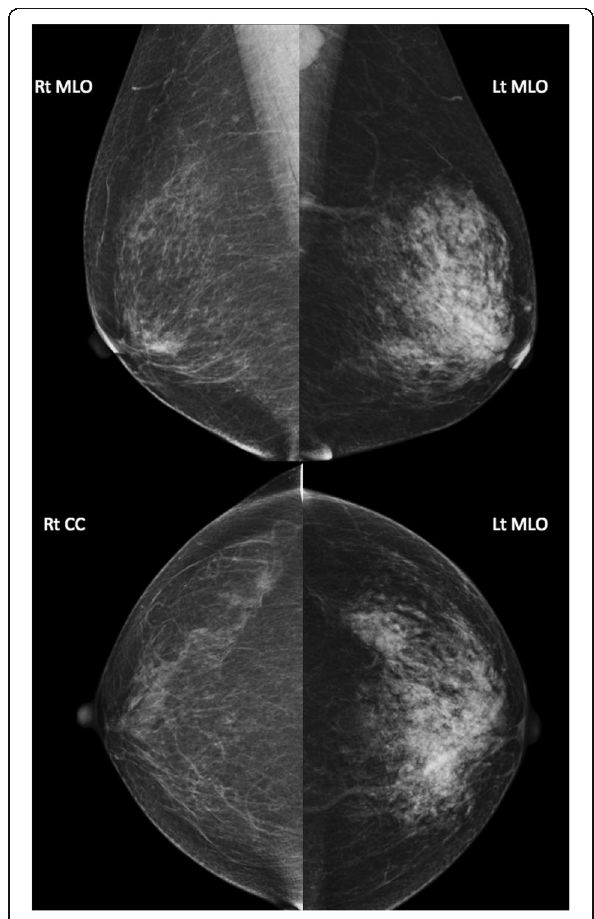
Fig. 1 Mammography findings. Medio-lateral oblique (MLO) and cranio-caudal (CC) images are shown. No apparent tumor shadow or calcification was observed in the bilateral mammary gland tissues. However, obvious differences were observed between the left and right sides, leading to a diagnosis of asymmetric breast tissue (category 3). In the left breast MLO, there is an axillary lymph node which seems to be reactive